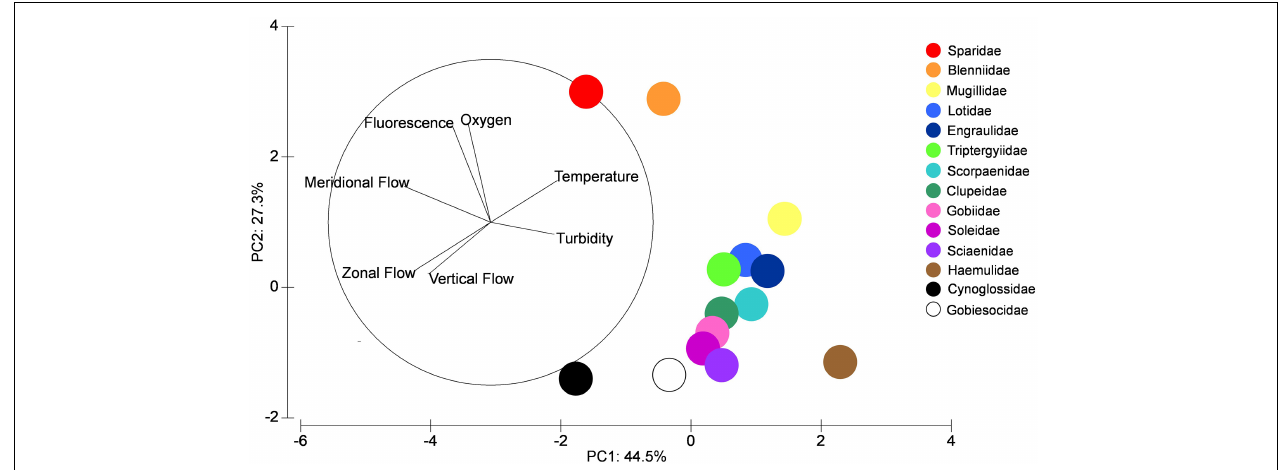
FIGURE 6 | PCA analysis showing percentage variability for each PC axis for larval fish families for all samples during the four frontal events within the coastal nearshore of Sardinia Bay region during the study (December 2014–May 2015).